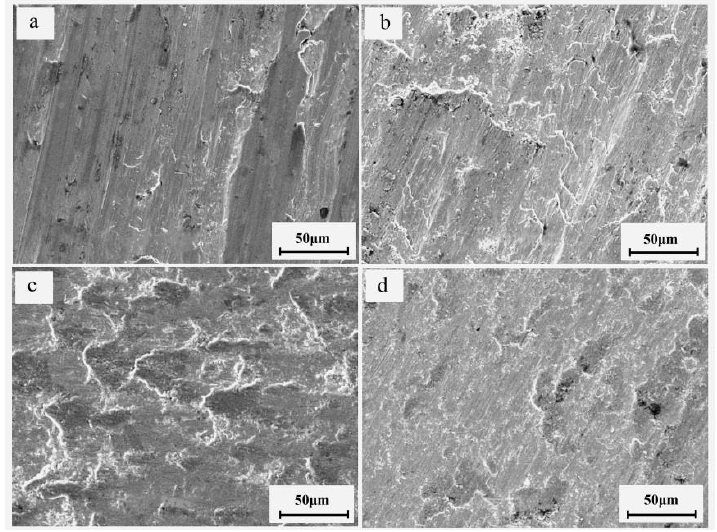
Figure 8. Morphology of different overlays after friction and wear. ( a ) matrix (2Cr13); ( b ) 5Cr13; ( c ) 8Cr13; ( d ) 8Cr13MoV.